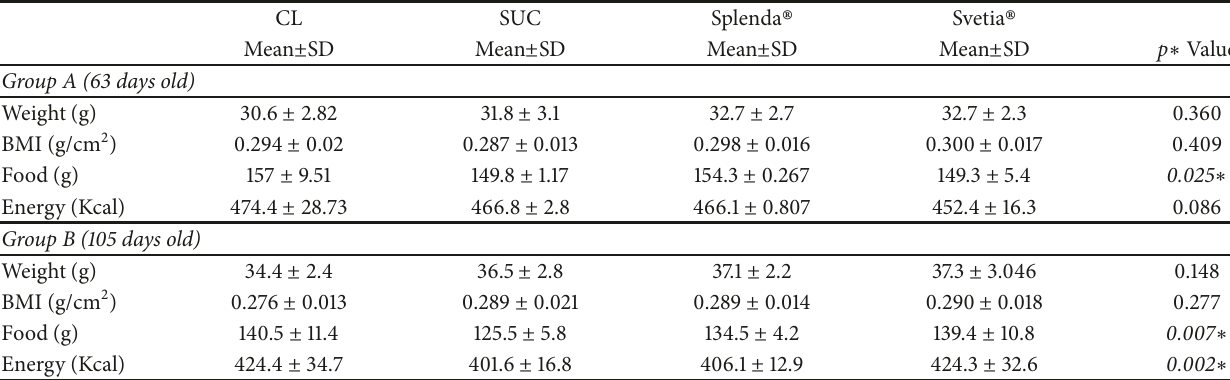
Table 1: Morphometric values and consumption of food and